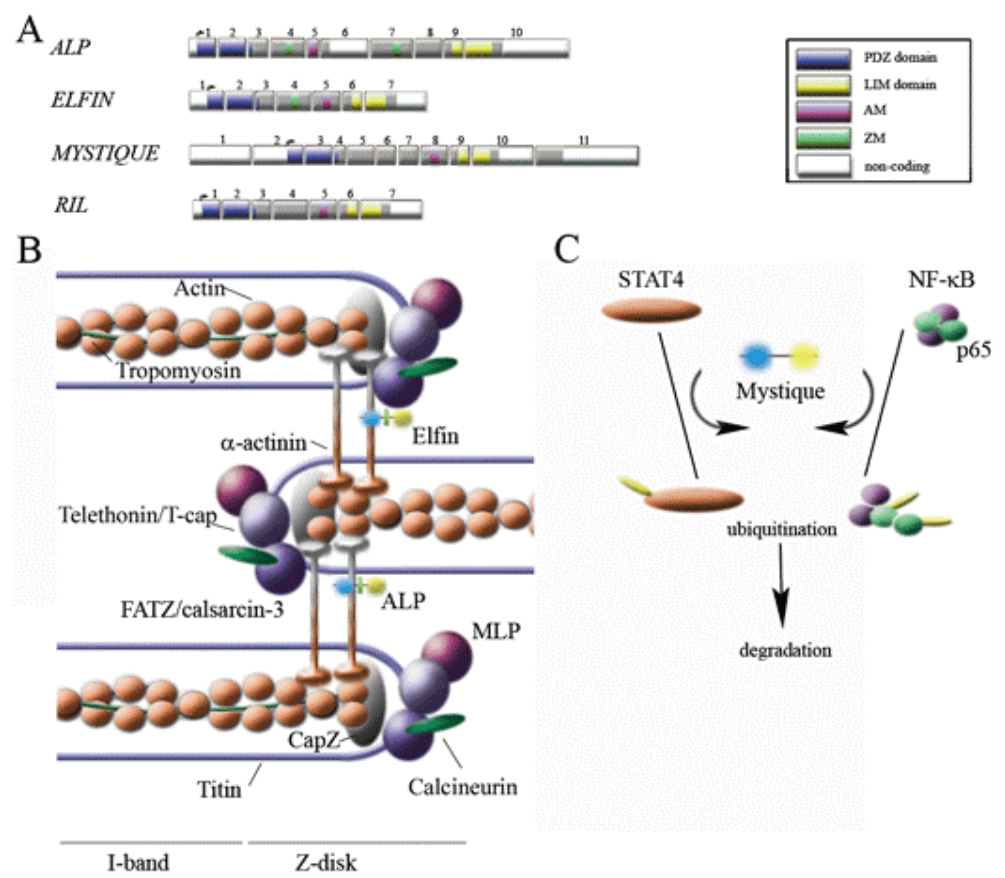
FIGURE 2 . (A) The gene architectures of the ALP subfamily. The structures depicted are based on the following Ensembl references: ALP (ENSG00000154553), ELFIN (ENSG00000107438), MYSTIQUE (ENSG00000120913), and RIL (ENSG00000131435). The color-coding scheme is similar to that of Fig. 1, but unlike the Enigma subfamily, the ALP subfamily encodes an ALP-like motif (AM), which is indicated in purple. (B) Molecular interactions of the ALP subfamily. Shown is a simplified overview of the proteins in the sarcomere, highlighting the interactions mediated by the proteins of the ALP subfamily. The PDZ domains of the proteins in the ALP subfamily interact with α -actinin, which is bound to, for example, actin and titin. The interactions mediated by the LIM domains of the ALP subfamily proteins are unknown at present, but it is likely that they present docking sites for kinases. (C) E3 ligase activity of Mystique. Mystique not only functions in close association with the cytoskeleton, it has also been shown to function as an ubiquitin ligase. Its primary targets have so far been identified as the p65 subunit of NF- κ B and both STAT-2 and STAT-4. It is not known where the ligating activity is located within the Mystique